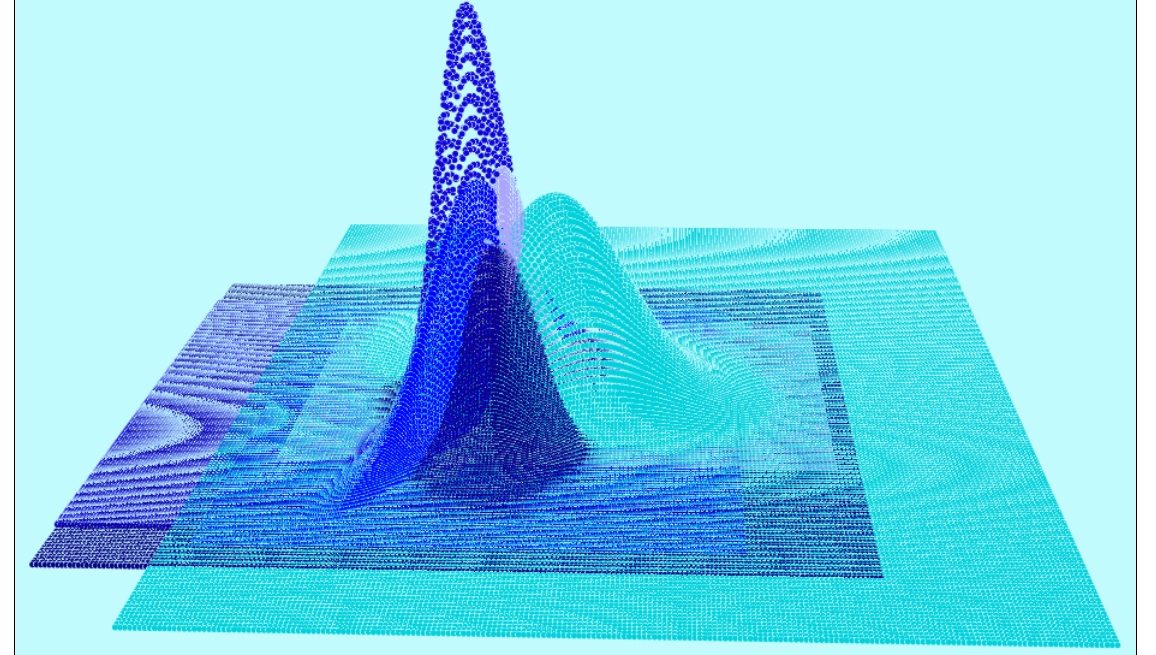
Figure 2. The five probability density functions ( UD s) of the tracked lesser kestrels are shown in different shades of blue. The X and Y axes represent easting and northing, respectively, and the Z axis measures the probability density that a lesser kestrel is found at a given point in a space.